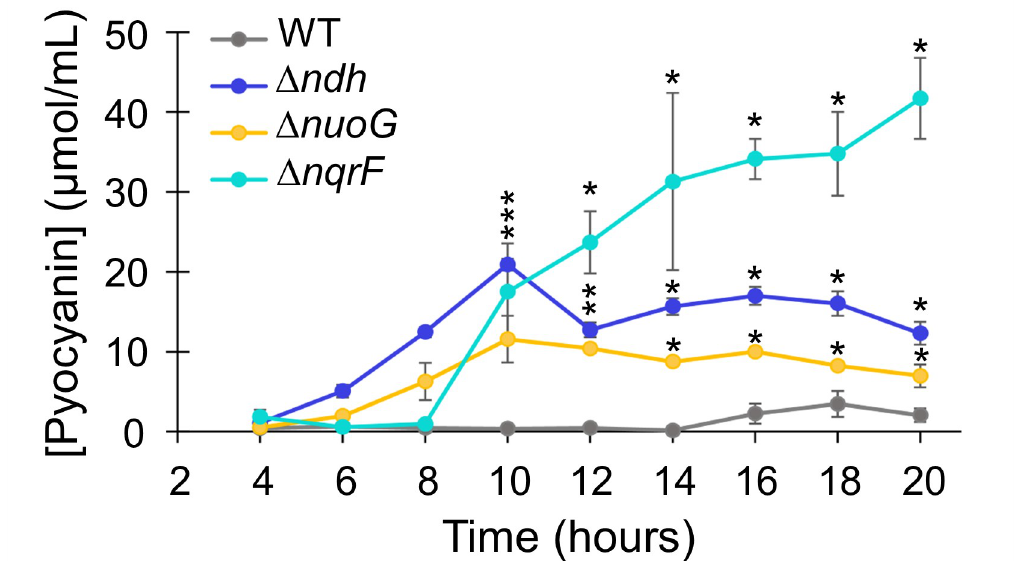
Fig 5. Pyocyanin production. Pyocyanin production in wild type PAO1 (grey), Δ ndh (dark blue), Δ nuoG (yellow) and Δ nqrF (cyan). The concentration ( μ M) was determined using the extinction coefficient for pyocyanin at 690 nm (4130 M -1 cm -1 ). OD 600 of the wild type and mutant cultures were similar at each time point, so data represent an accurate comparison of pyocyanin production in the different strains. Stars indicate p-values from a student’s t -test � 0.05, compared to wild type at each time